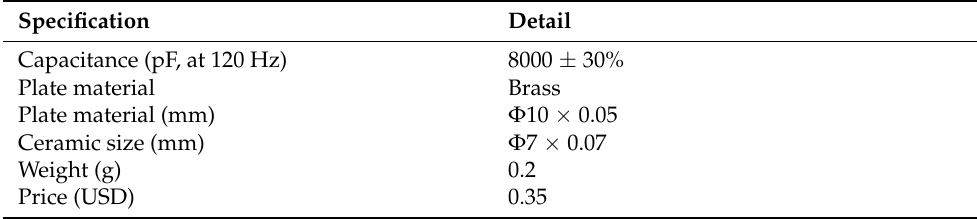
Figure 5. ( a ) VF and ( b ) signal amplifier and gain adjust. Table 1. Piezoelectric sensor